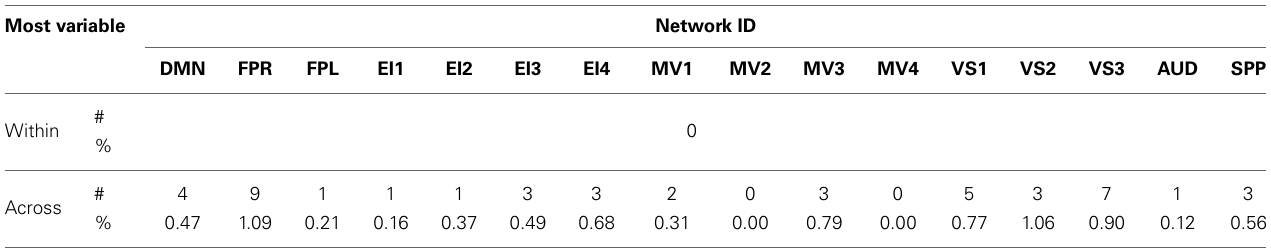
Table 3 | Absolute (#) and relative (%) number of connections with positive high CVAR (most variable) for each network. Most